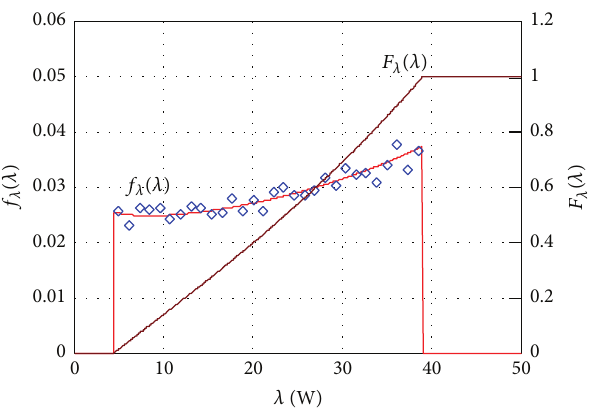
Figure 4: pdf and CDF of the maximum power obtained by the analytical method (curves) and pdf obtained by the Monte Carlo method of 10 4 simulation trials (scattered dots).